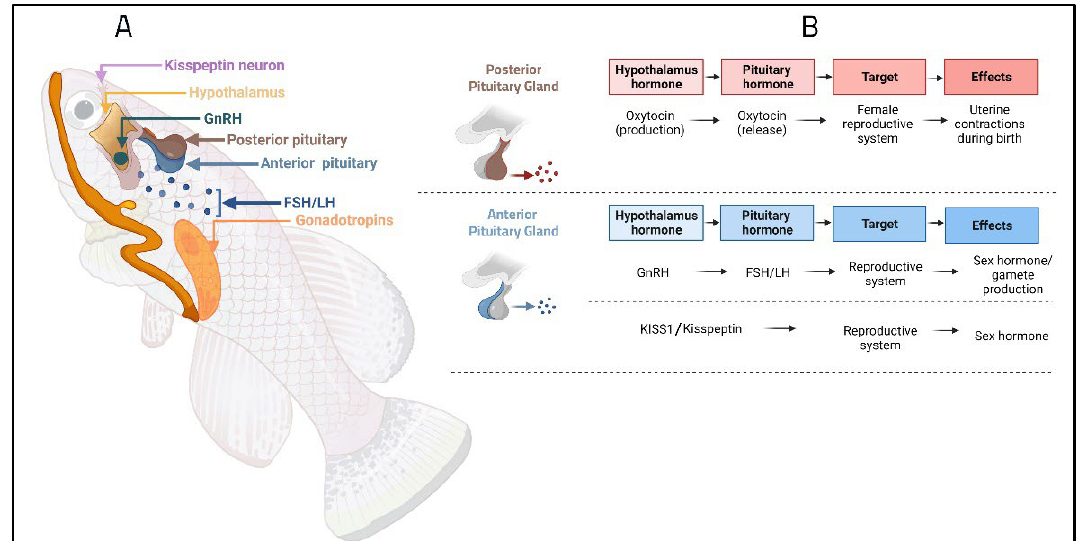
Figure 3. Demonstrating the specific genes or hormones associated with fish reproduction. ( A ) The left side represents, specific organs of fish from which the associated hormones/enzymes and genes are released. ( B ) The right portion demonstrates the posterior and anterior pituitary glands and genes of fish associated with fish reproduction. GnRH: gonadotrophin releasing hormone; FSH: follicle stimulating hormone; LH: luteinizing hormone; KISS: Kisspeptin-1.